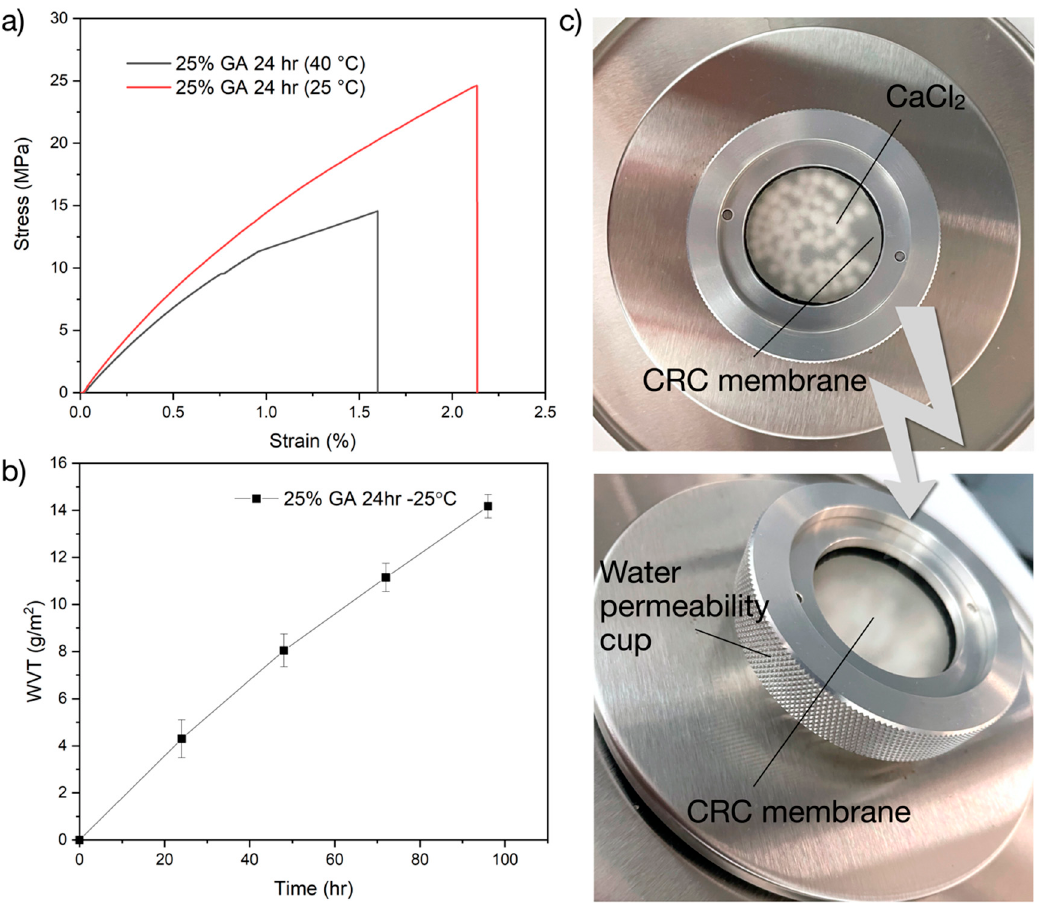
Figure 8. ( a ) Stress-strain curve for the CRC film crosslinked with 25% GA for 24 hr. ( b ) Water vapor transmission rate for 25% GA-CRC films crosslinked for 24 hr (curing at 25 °C). ( c ) Water permeability cup fixed with 25 °C-cured CRC-25% GA for 24 hr as a film, and CaCl 2 as a desiccant.